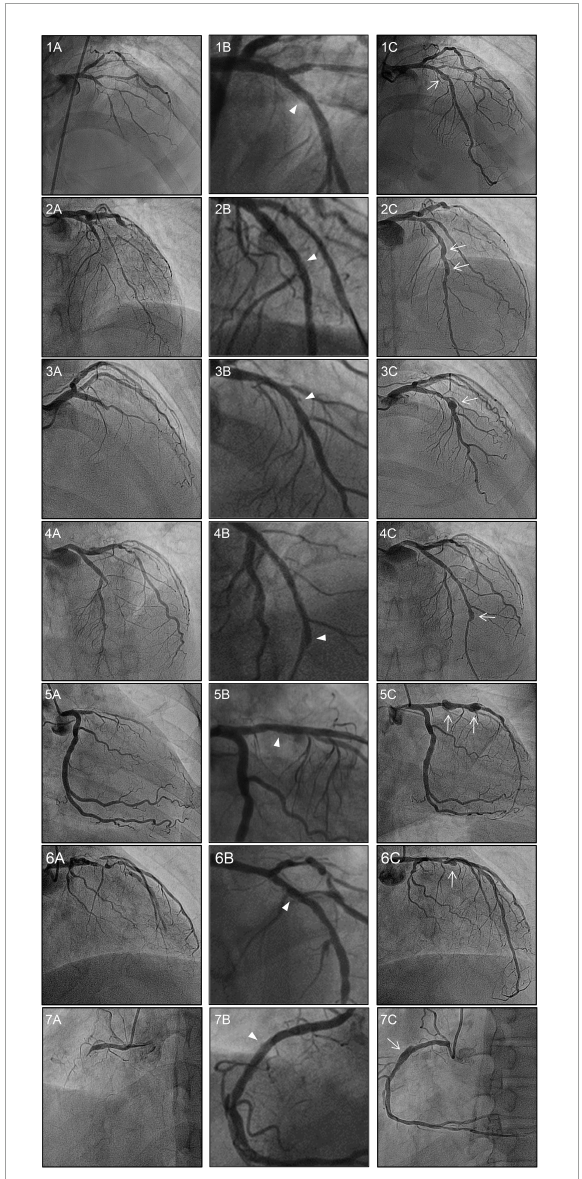
FIGURE2 Baseline, post-DCB, and follow-up coronary angiograms for the 7 cases of aneurysm formation. Angiograms presented were obtained (A) pre-procedure, (B) post-DCB; and (C) at follow-up. The dissections and aneurysms are shown by the arrowheads and arrows, respectively. All vessels were treated with drug-coated balloon alone for CTO lesions. The aneurysm developed at the inlet of the target lesion in six cases, with the exception of case 4 in which the aneurysm developed at the outlet of the CTO lesion. Of note, for case 2, aneurysms developed at the inlet and the mid-segment site; while for case 5, aneurysms developed at the inlet and outlet sites of the CTO lesion. DCB, drug-coated balloon; CTO, chronic total